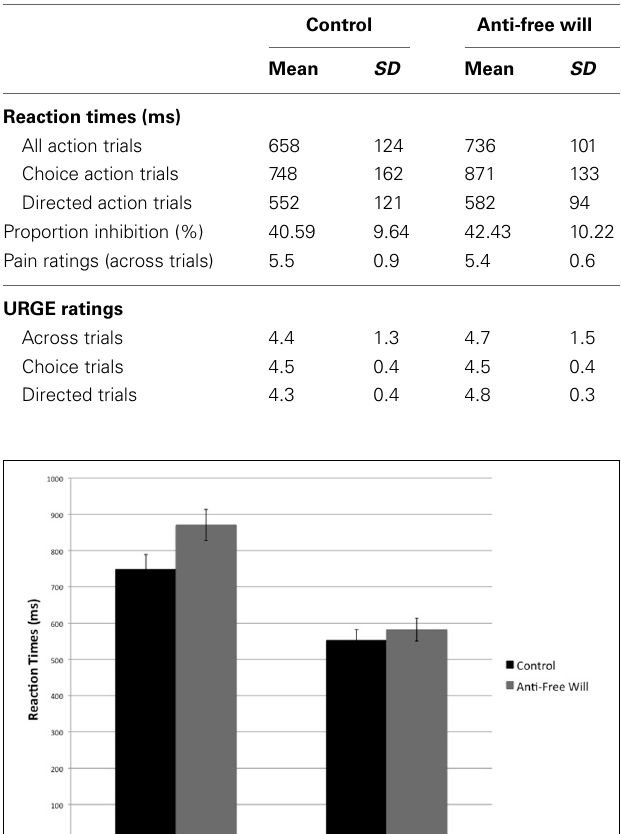
Table 1 | Between-group means and standard deviations.